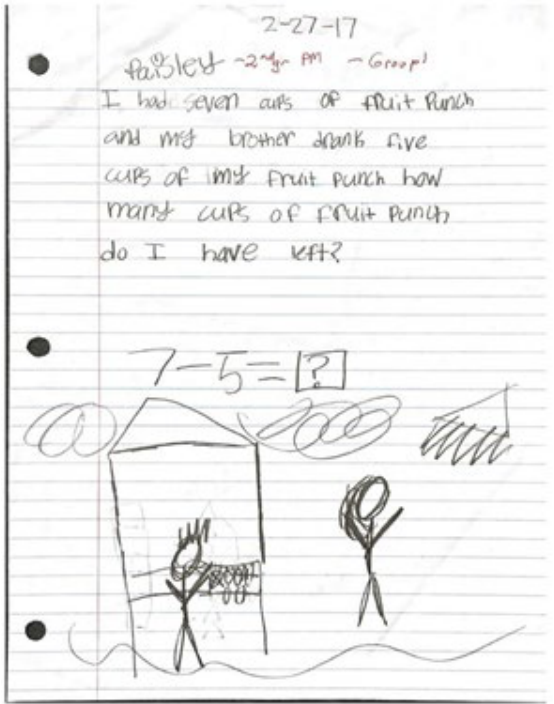
Figure 3. Paula’s work for Lesson